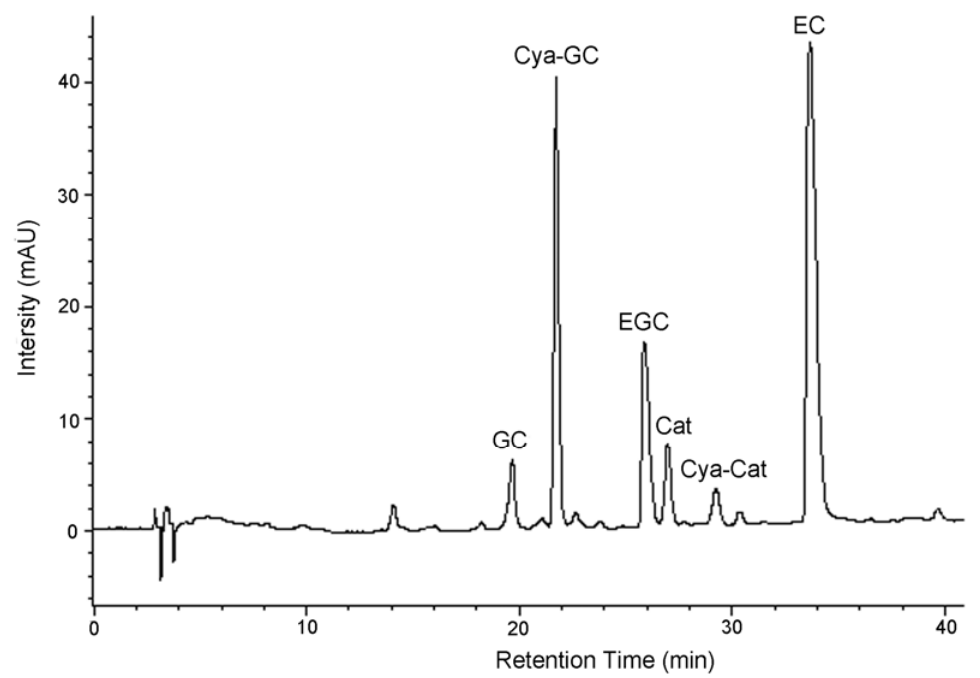
Figure 2. Reversed-phase HPLC chromatograms of condensed tannins from L . glaber leaves degraded in the presence of cysteamine; EC, (-)-epicatechin; Cat, (+)-catechin; EGC, (-)-epigallocatechin; GC, (-)-gallocatechin; Cya-Cat, 4 β -(2-aminoethylthio)catechin; Cya- GC, 4 β -(2-aminoethylthio) gallocatechin.